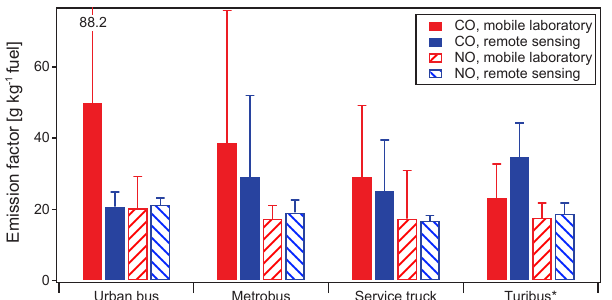
Figure 1. Comparison of average fuel-based emission factors (gkg − 1 fuel) between the mobile laboratory and remote sensing techniques by vehicle type. Variability bars represent 1 standard de- viation of the observed values. ∗ Turibuses are fueled by biodiesel